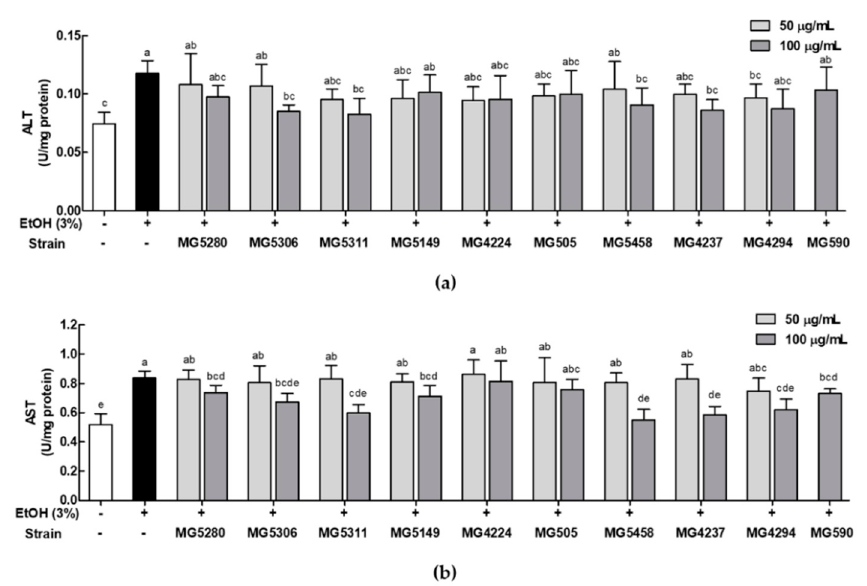
Figure 4. Inhibition of ( a ) ALT and ( b ) AST levels by CFEs from LAB strains in ethanol-induced HepG2 cells. Data are expressed as mean ± SD ( n = 3). Different letters on the column indicate significance at p < 0.05 based on Duncan’s test. EtOH,